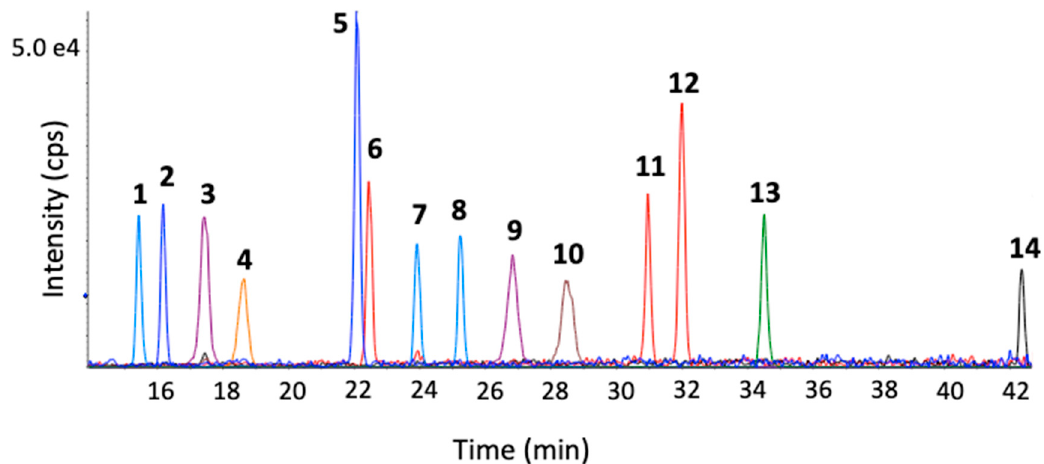
Figure 2. Representative LC-MRM chromatograms from a 20 µ L injection of IS mix containing 0.013-0.1 µ M final concentration of each IS compound. (1) d4-GUDCA (2) d4-GCA (3) d4-TUDCA (4) d4-TCA (5) d4-CA (6) d4-UDCA (7) d4-GCDCA (8) d4-GDCA (9) d4-TCDCA (10) d6-TDCA (11) d4-CDCA (12) d4-DCA (13) d4-GLCA (14) d4-LCA.